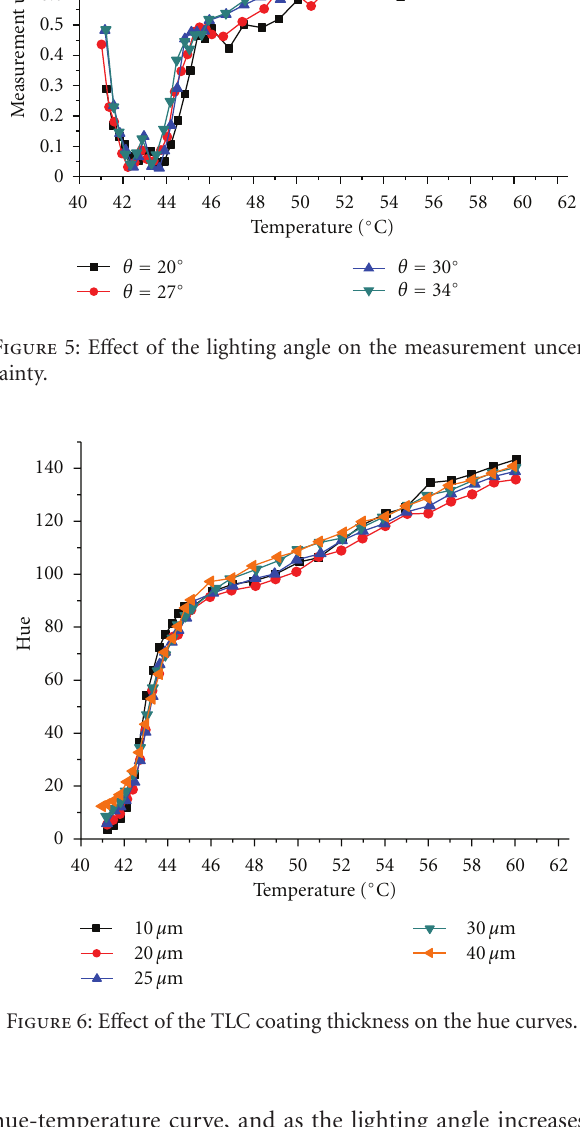
hue-temperature curve, and as the lighting angle increases, the hue curve shifts upward.